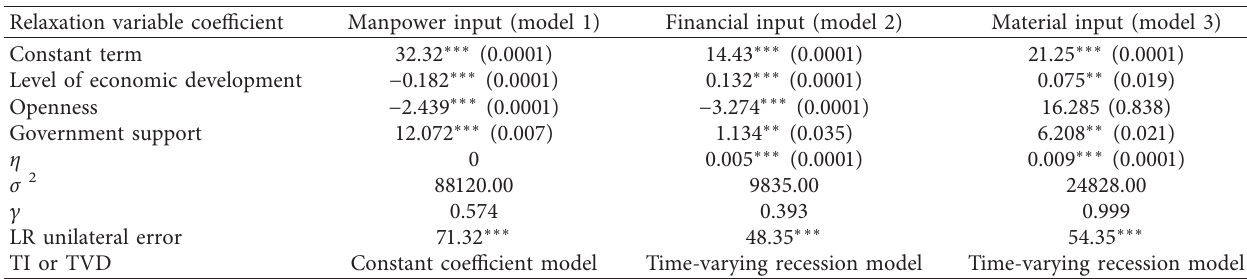
Table 4: Panel SFA regression results of the second stage.